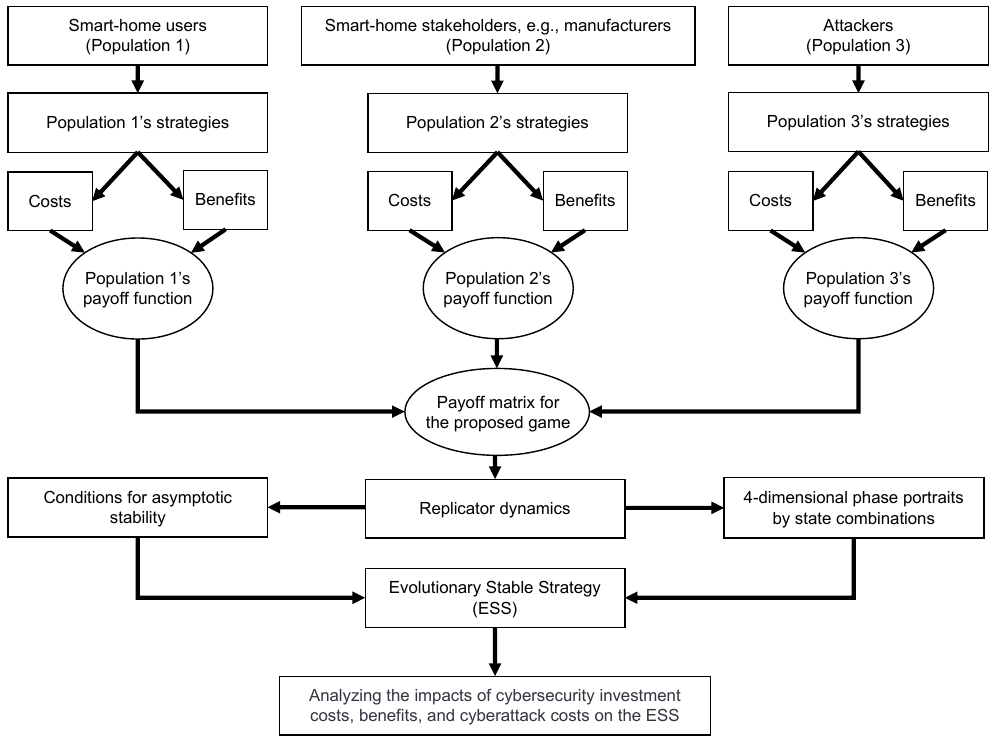
Figure 1. Flowchart of the proposed